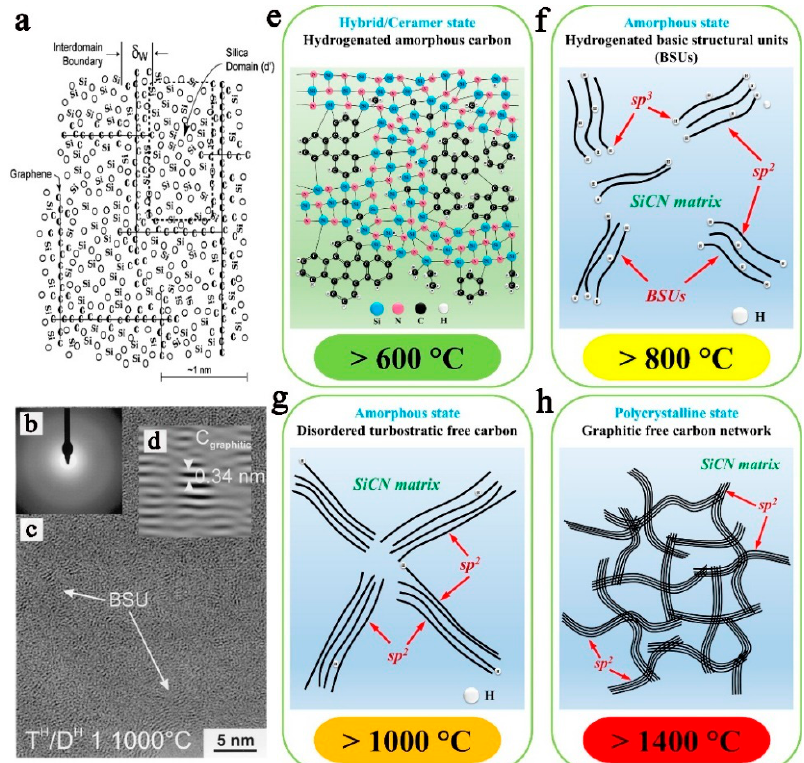
Figure 1. A model of polymer derived ceramics (PDCs) nanodomain ( a ); high-resolution TEM micrographs of the typical amorphous structure of PDCs ( c ) pyrolyzed at 1000 ◦ C. The inset ( b ) displays the selected area electron di ff raction (SAED) patterns, indicating the amorphous feature. The inset ( d ) shows a basic structural unit (BSU) of free carbon with an interplanar distance of around 0.34 nm between the graphene layers; the structural evolution of PDCs at di ff erent pyrolysis temperatures: > 600 ◦ C ( e ), > 800 ◦ C ( f ), > 1000 ◦ C ( g ) and > 1400 ◦ C ( h ) [34]. Reproduced with permission from Yu Z., Prog. Mater. Sci.; published by Elsevier,